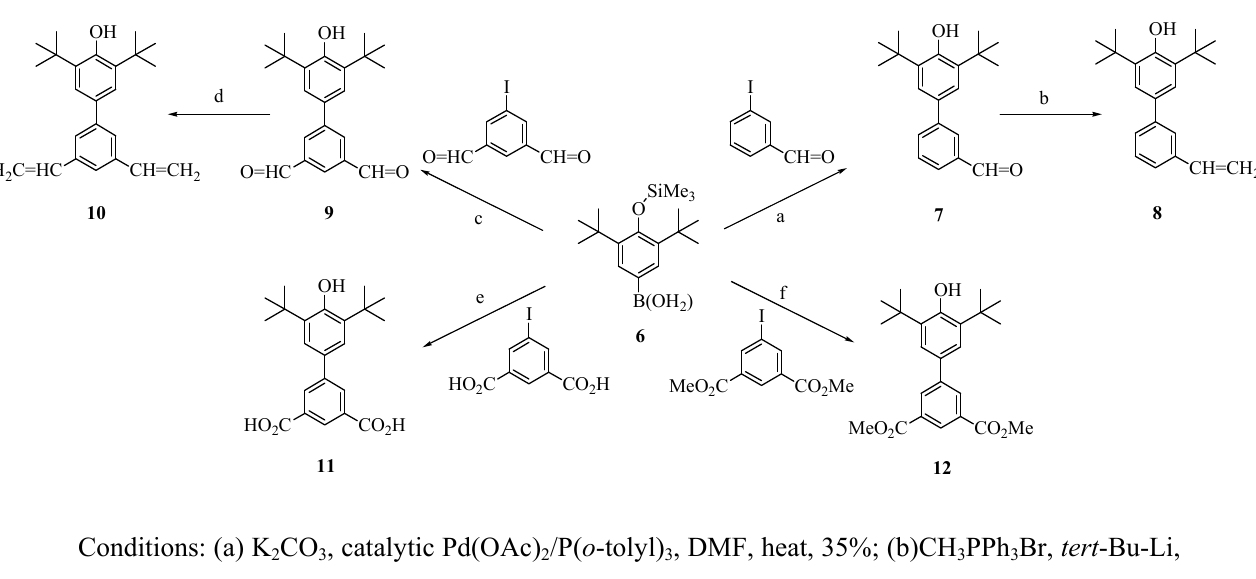
Figure 2. Synthesis of fragment model segments related to polymer 2